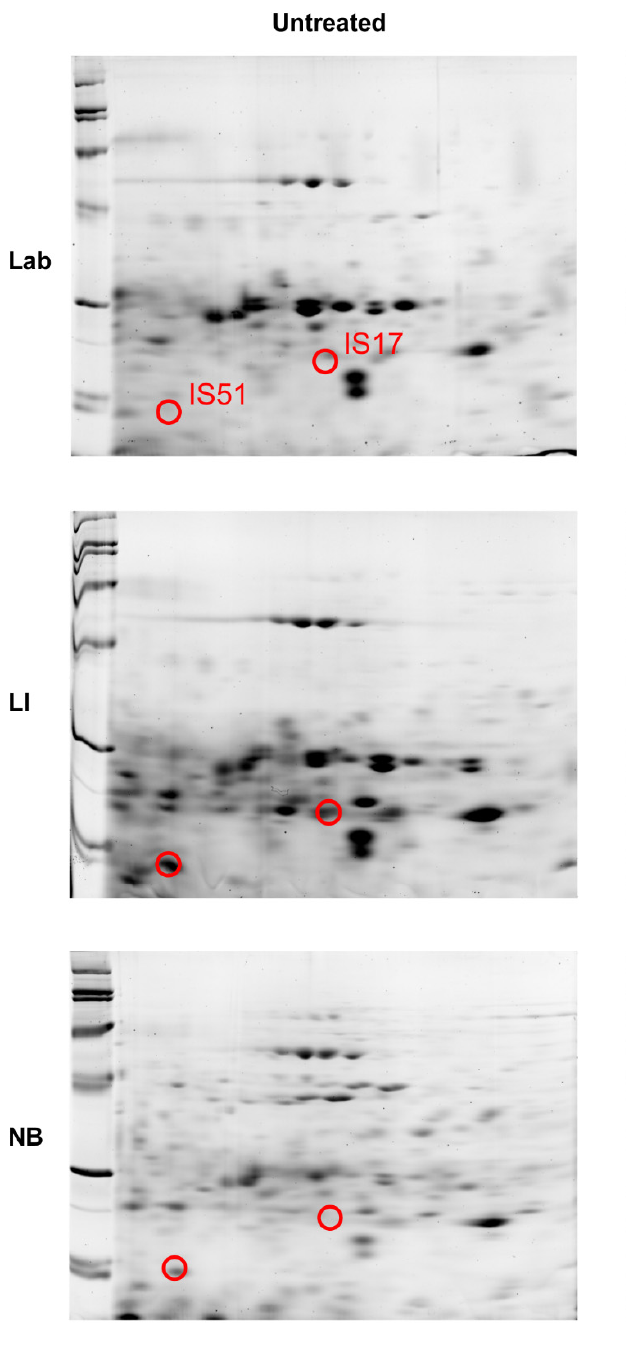
Figure 6. 2D PAGE gel separations of adult Colorado potato beetle midgut tissue proteins from insecticide susceptible (Lab), resistant (LI) and tolerant (NB) strains. Strips 18 cm in length were run at pH 4–7 and cut to 7 cm. The location of two high concentration protein spots (IS17 and IS51) in the resistant strain (LI) were marked in the gels for each strain, either pre-treated with imidacloprid or untreated.